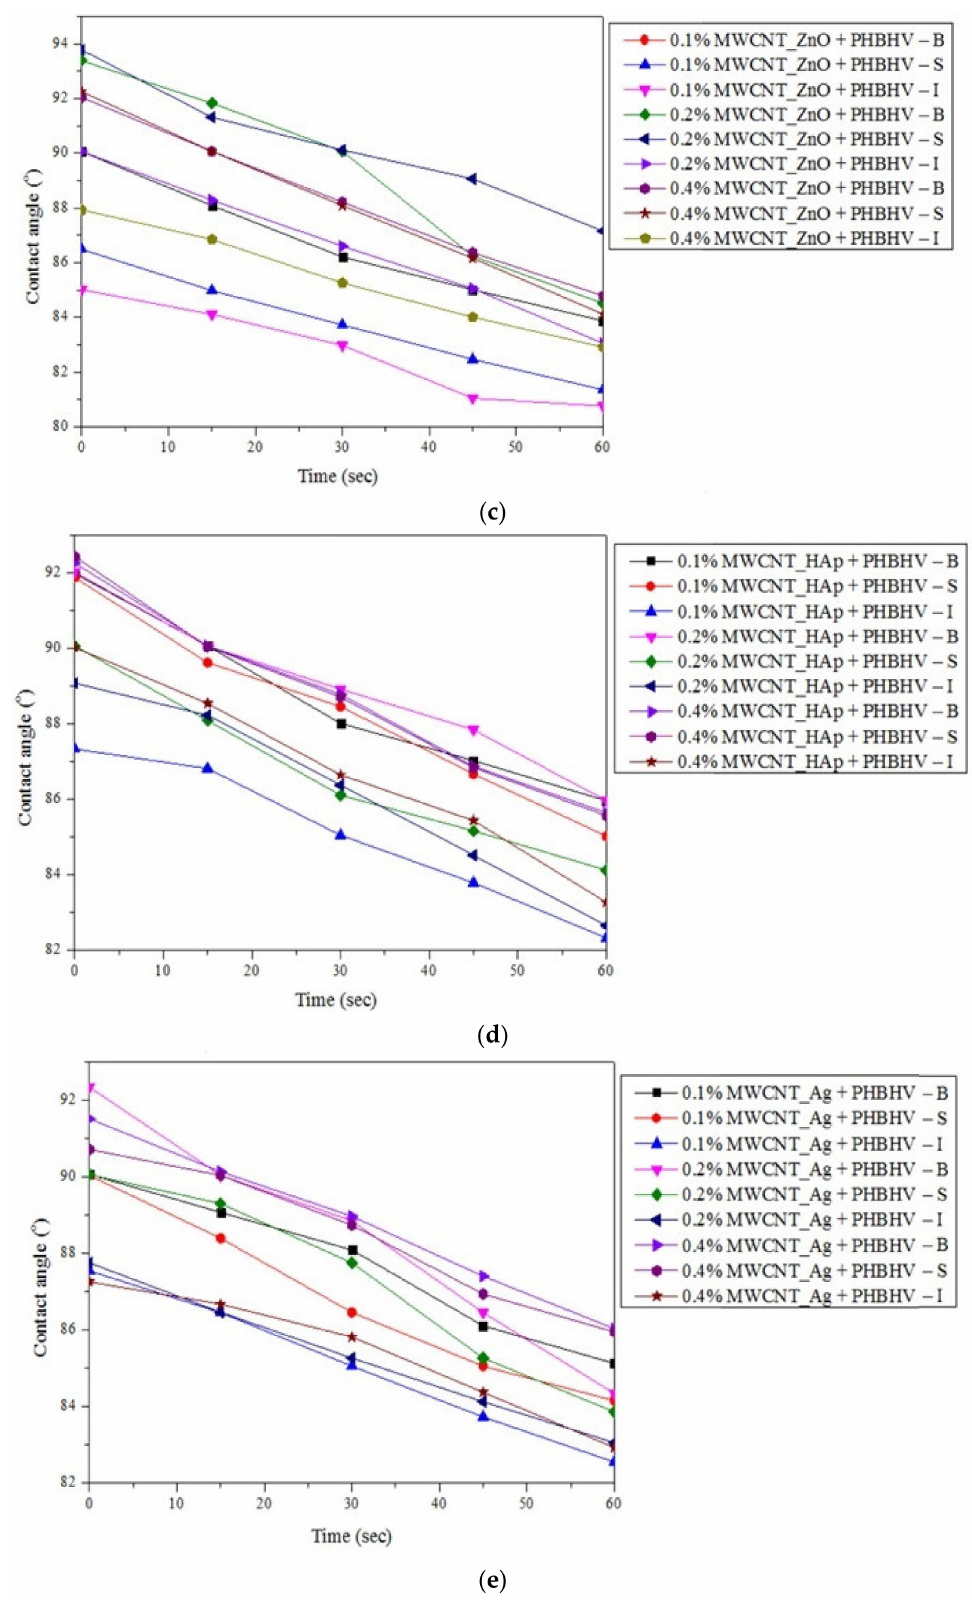
Figure 8. Calculated contact angles for untreated ( a ) and treated samples with ( b ) MWC- NTs + PHBHV set, ( c ) MWCNTs_ZnO + PHBHV set, ( d ) MWCNTs_HAp + PHBHV set and ( e ) MWC- NTs_Ag + PHBHV